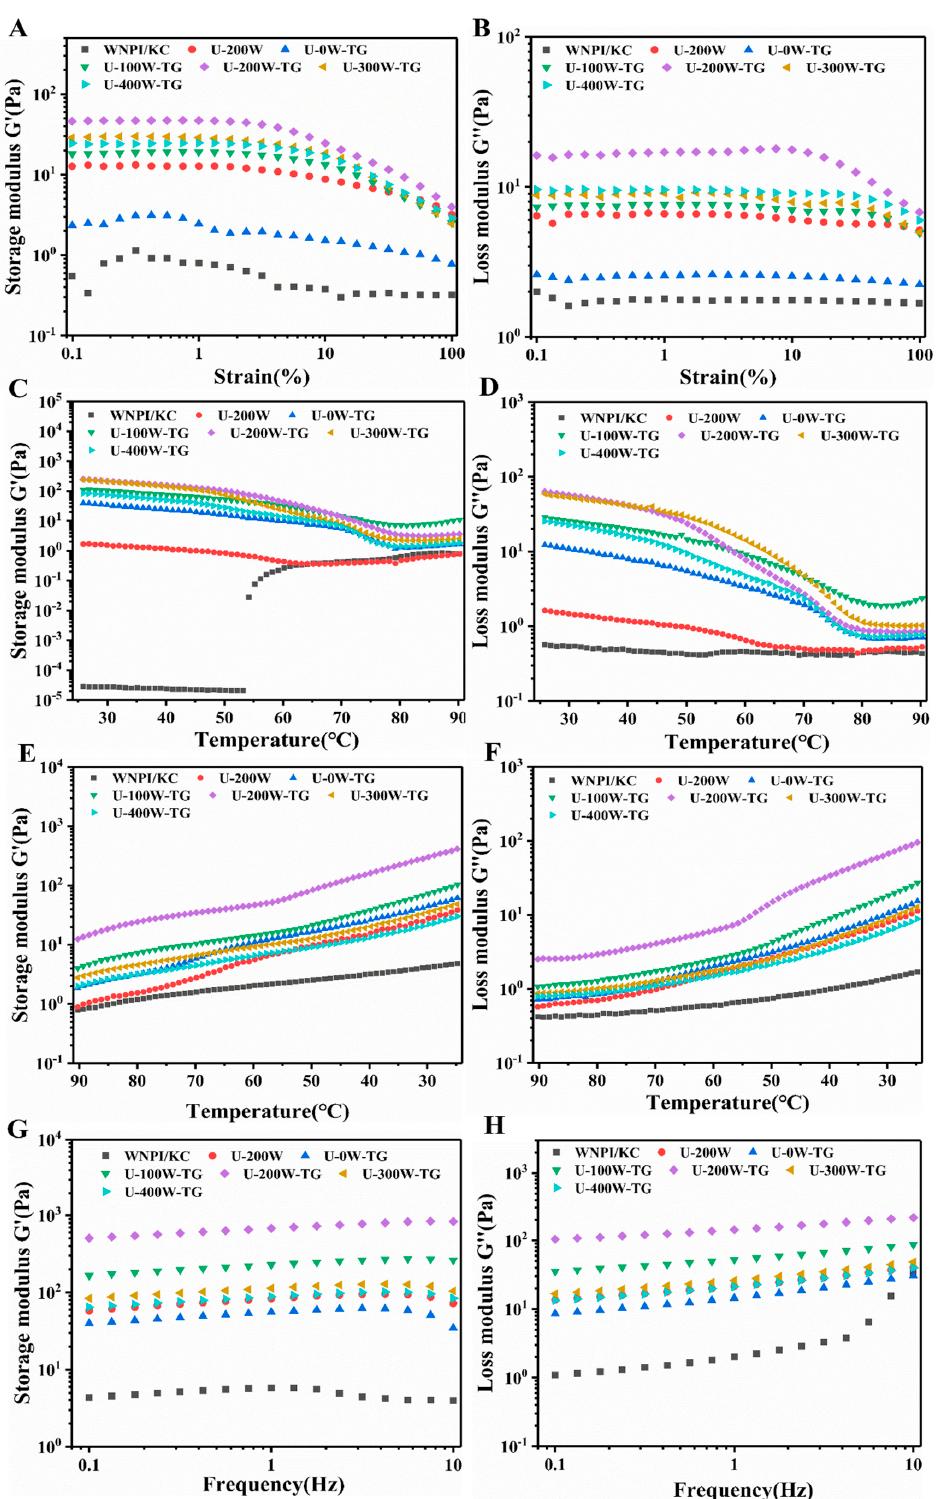
Figure 3. Effects of ultrasonic power on rheological properties of WNPI-KC composite gels. ( A , B ) Storage modulus (G’) and loss modulus (G”) of composite gel samples with ultrasound during strain sweep; ( C , D ) G’ and G” of the composite gel samples with ultrasound during heating process; ( E , F ) G’ and G” of the composite gel samples with ultrasound during cooling process; ( G , H ) G’ and G” of the composite gel samples with ultrasound during frequency